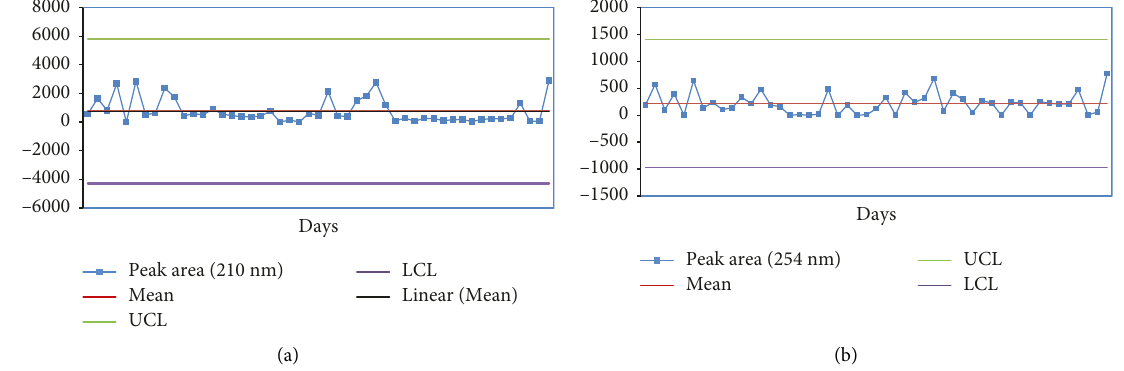
Figure 5: Control chart (six-sigma limits) indicating the trend of HPLC global peak area (a) at 210nm and (b) 254nm of fresh lab water (18.2M Ω × cm at 25 ° C) over time ( n � 49 days/year). UCL: upper control limit; LCL: lower control